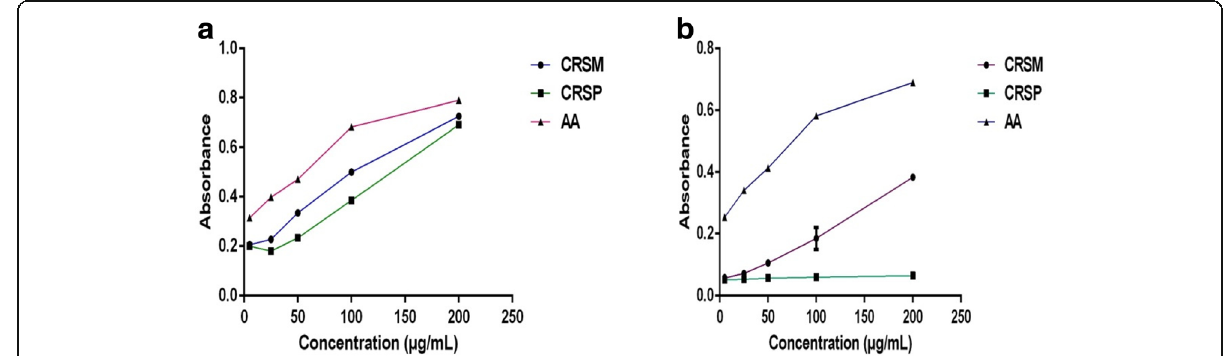
Fig. 1 a Cuprac reducing capacity assessment of CRSM, CRSP and standard. Values are presented as mean ± standard deviation ( n = 2) ( b ) Reducing power capacity assessment of two different seed extracts and standard. Values are presented as mean ± SD ( n =